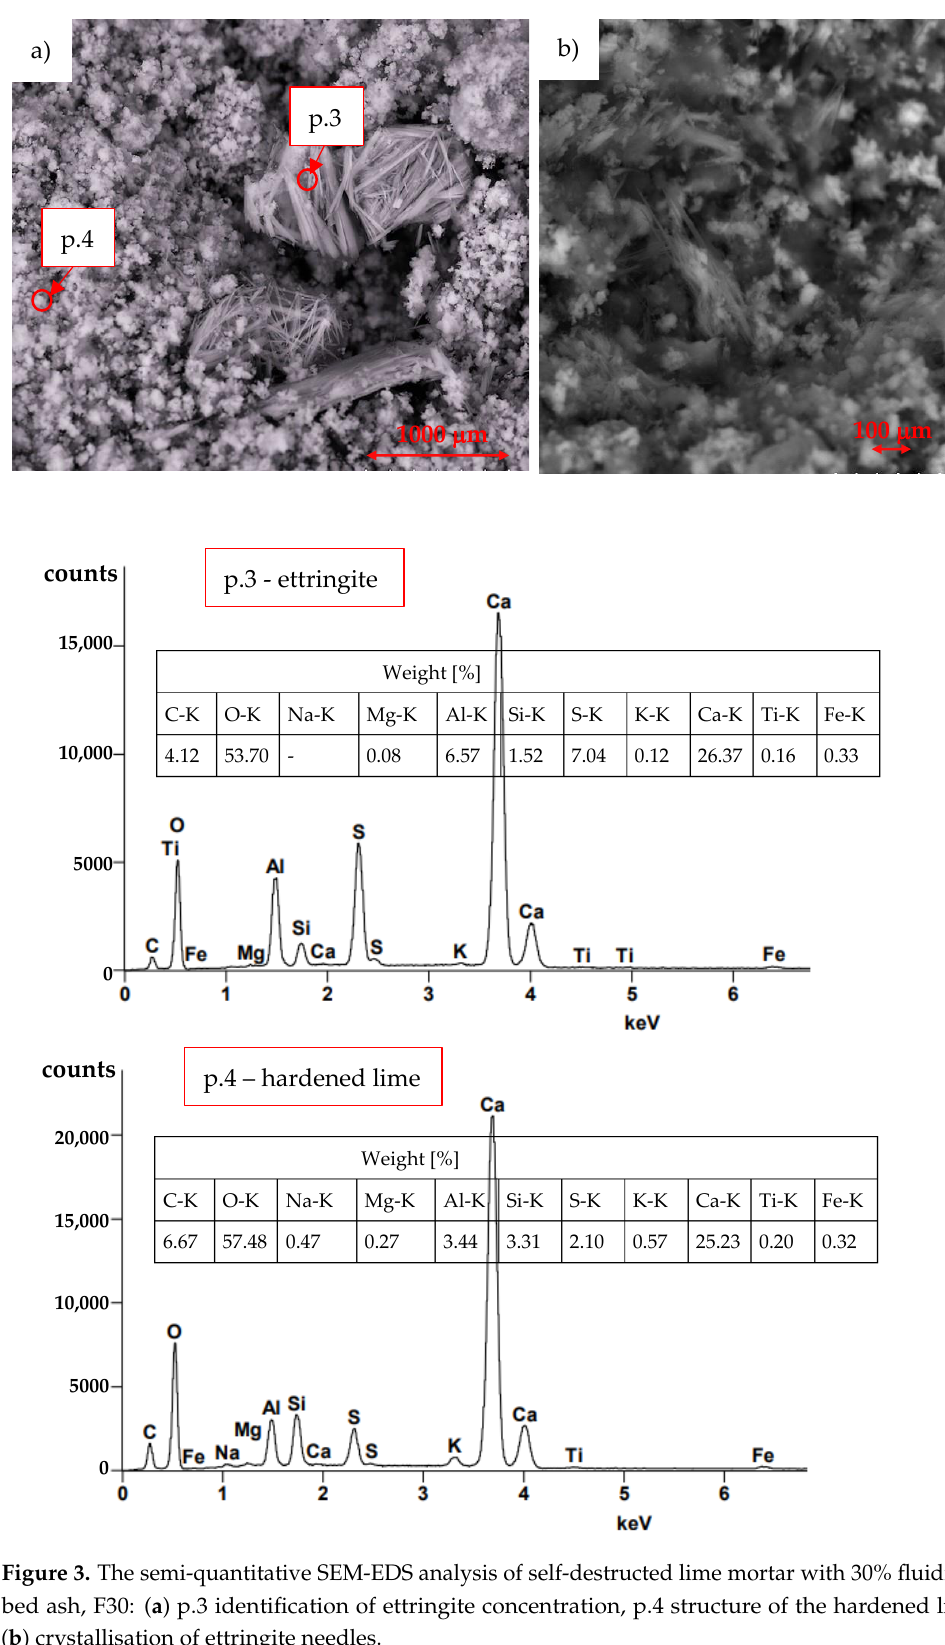
Figure 3. The semi-quantitative SEM-EDS analysis of self-destructed lime mortar with 30% fluidised bed ash, F30: ( a ) p.3 identification of ettringite concentration, p.4 structure of the hardened lime, ( b ) crystallisation of ettringite needles.